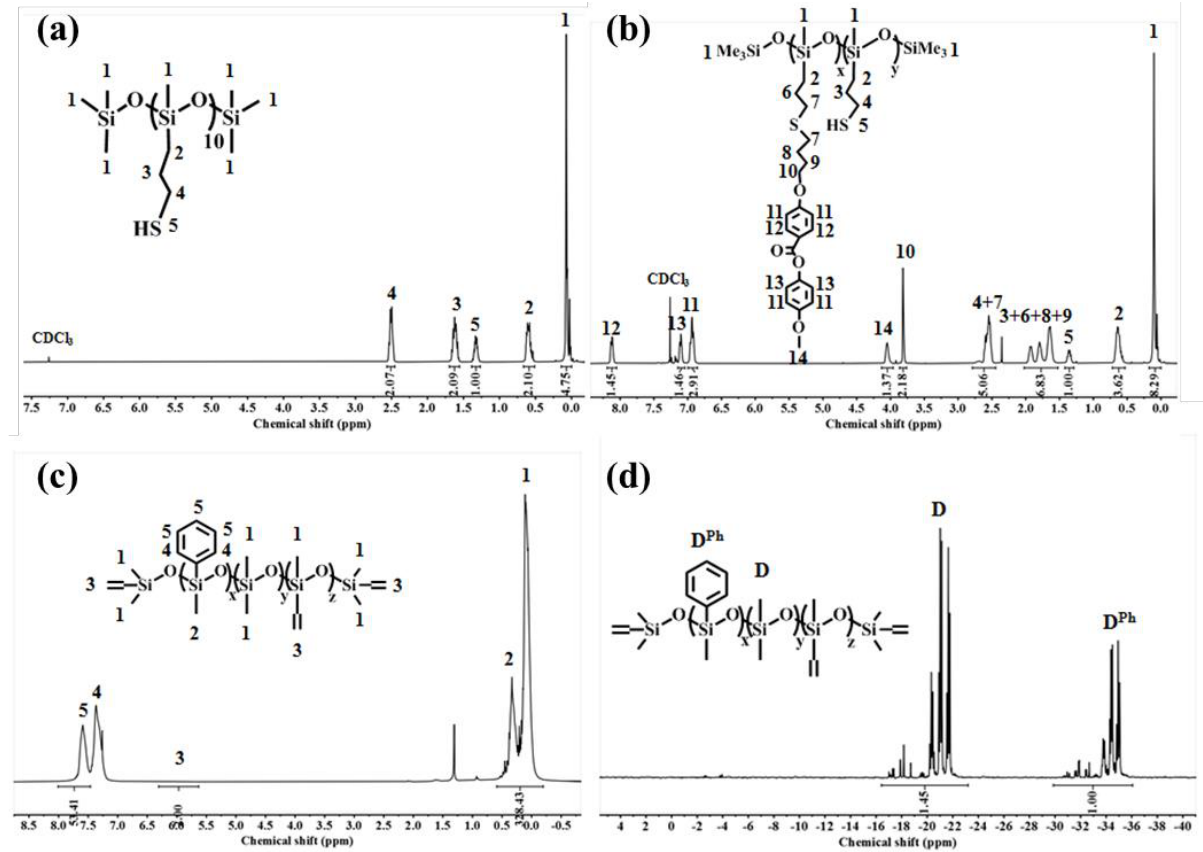
Figure 1. 1 H NMR spectra of ( a ) SHSO, ( b ) SHSO- g -MBB, ( c ) silicone oil with 40% phenyl content in CDCl 3 and ( d ) 29 Si NMR spectra of silicone oil with 40% phenyl content in CDCl 3